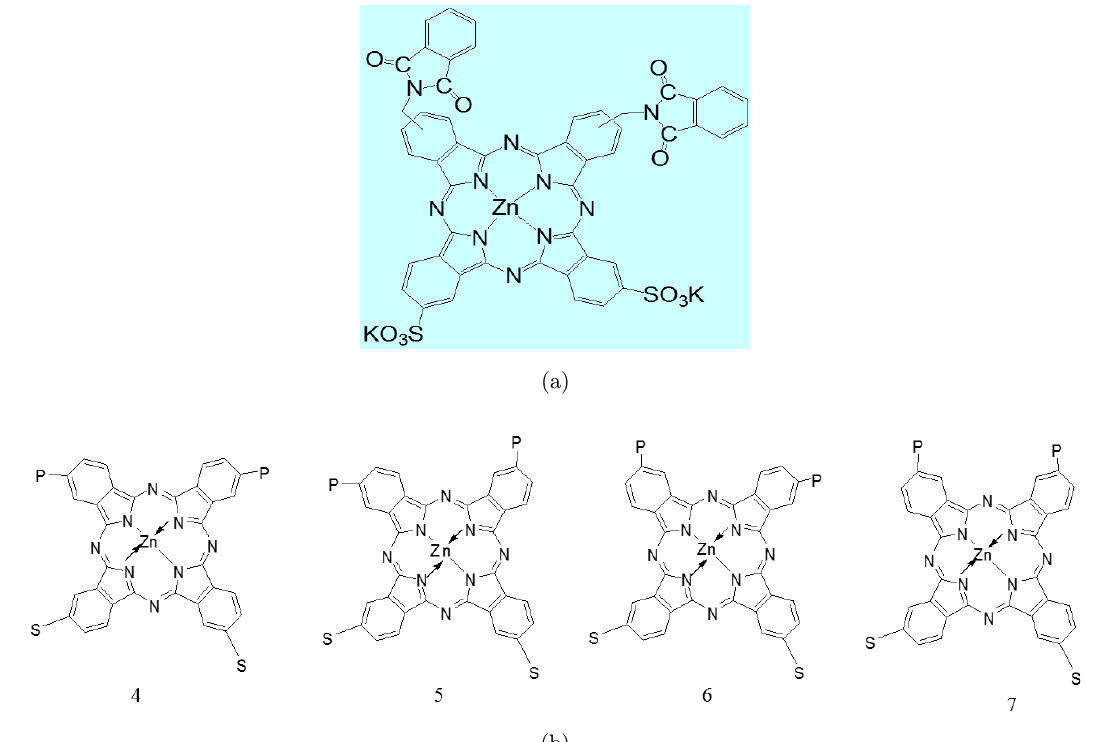
Fig. 1. (a) Chemical structure of Photocyanine; (b) explicit isomer composition of Photocyanine.